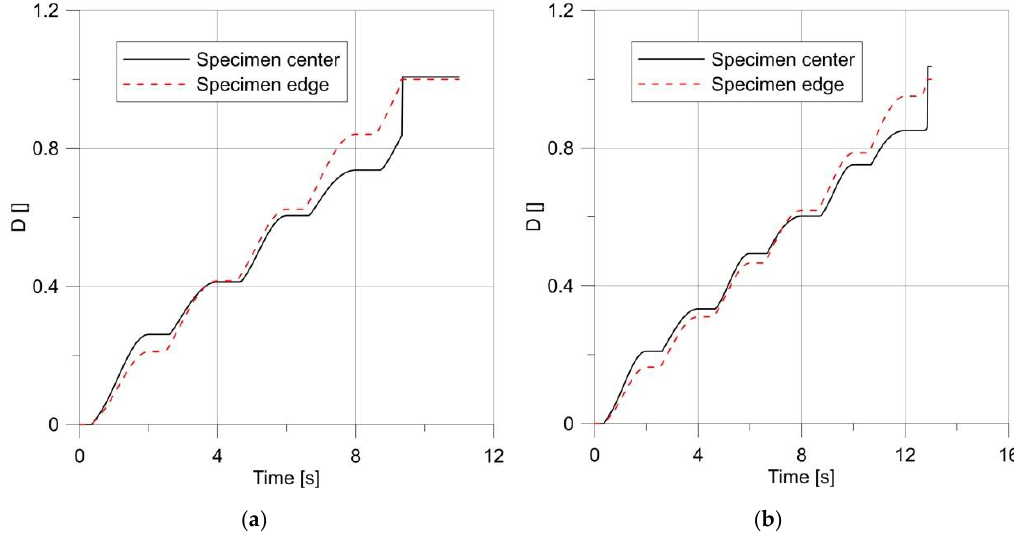
Figure 18. Changes in parameter D under a load, for specimens with notch radius R = 5.0 mm ( a ) and R = 10 mm( b ).